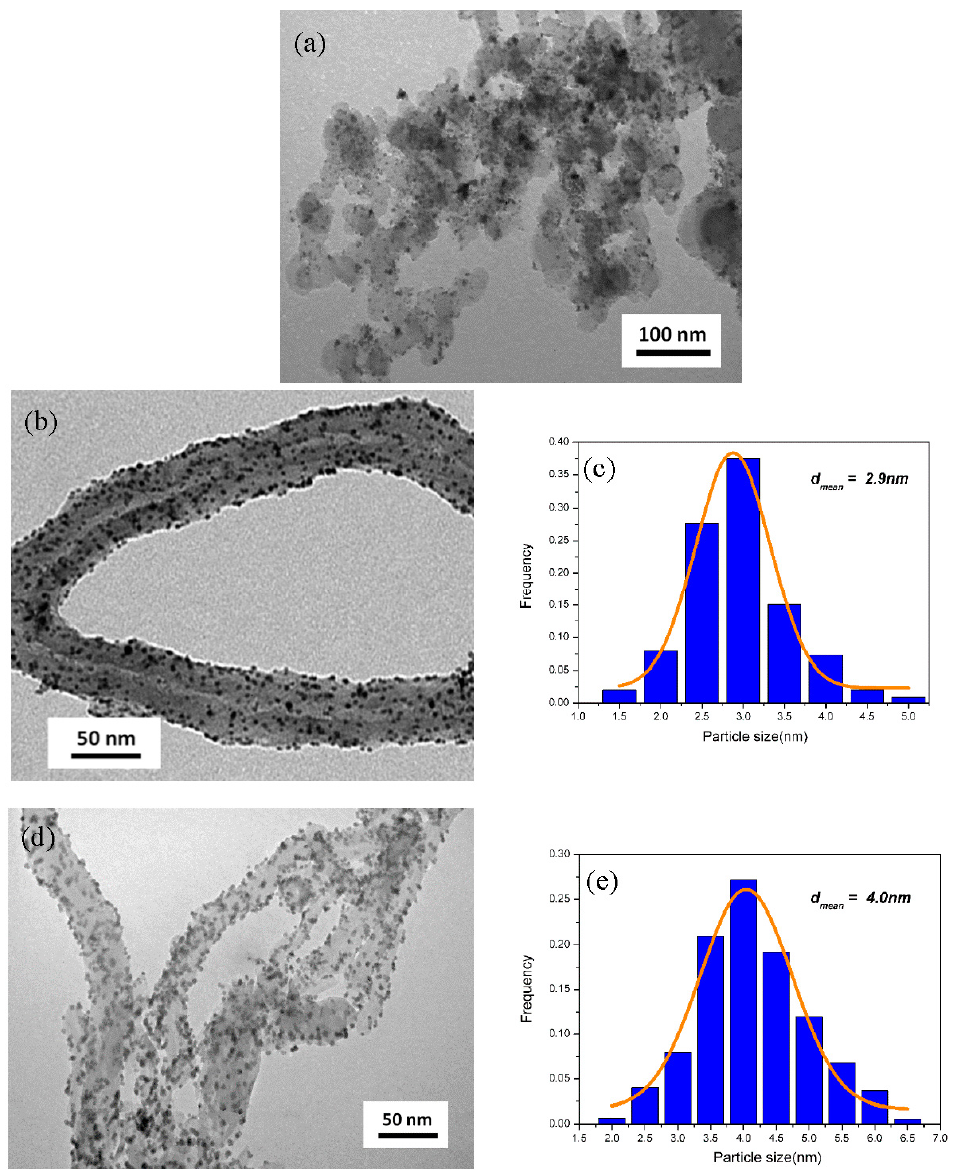
Figure 4. Transmission electron microscope (TEM) images and the corresponding particle size distribution of ( a ) Pt/XC ‐ 72; ( b , c ) Pt/PEI ‐ MWCNTs; and ( d , e ) PtSn/PEI ‐ MWCNTs.